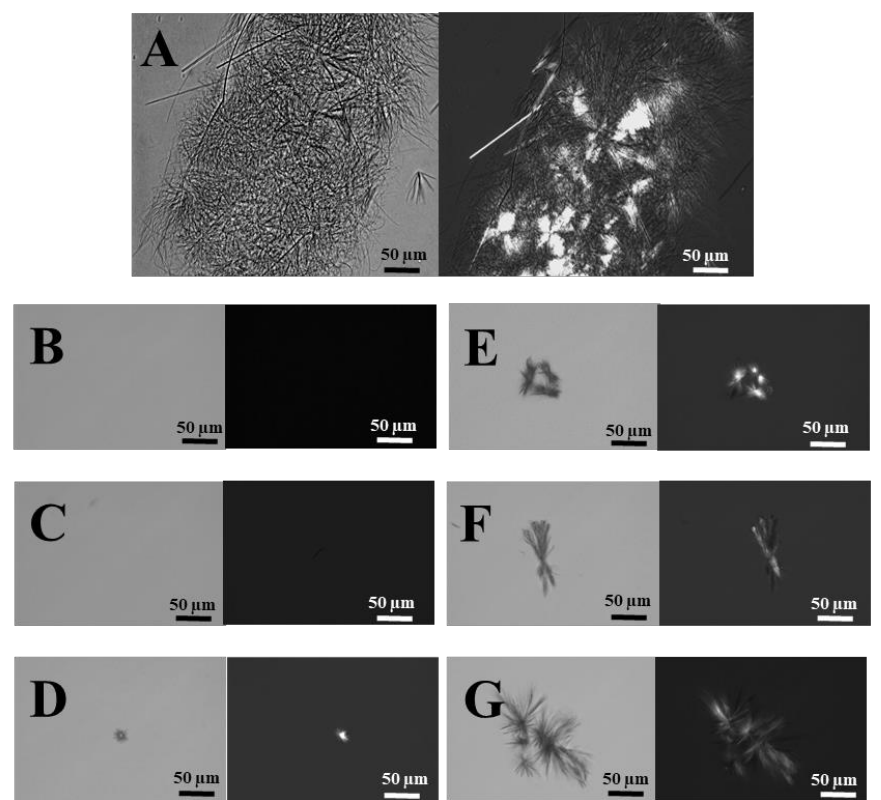
Figure 4. Bright field ( left ) and polarized light ( right ) microscopy images (scale bars = 50 µm) of ( A ) non- encapsulated PTX (80 μM); ( B ) 2:1, ( C ) 4:1, ( D ) 6:1, ( E ) 8:1, ( F ) 10:1, ( G ) 12:1 molar ratio of PTX to FITC-HA-BSA conjugate NPs.